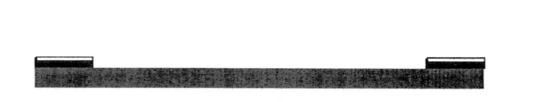
FIGURE 7 Minimum damping solution for sand wich